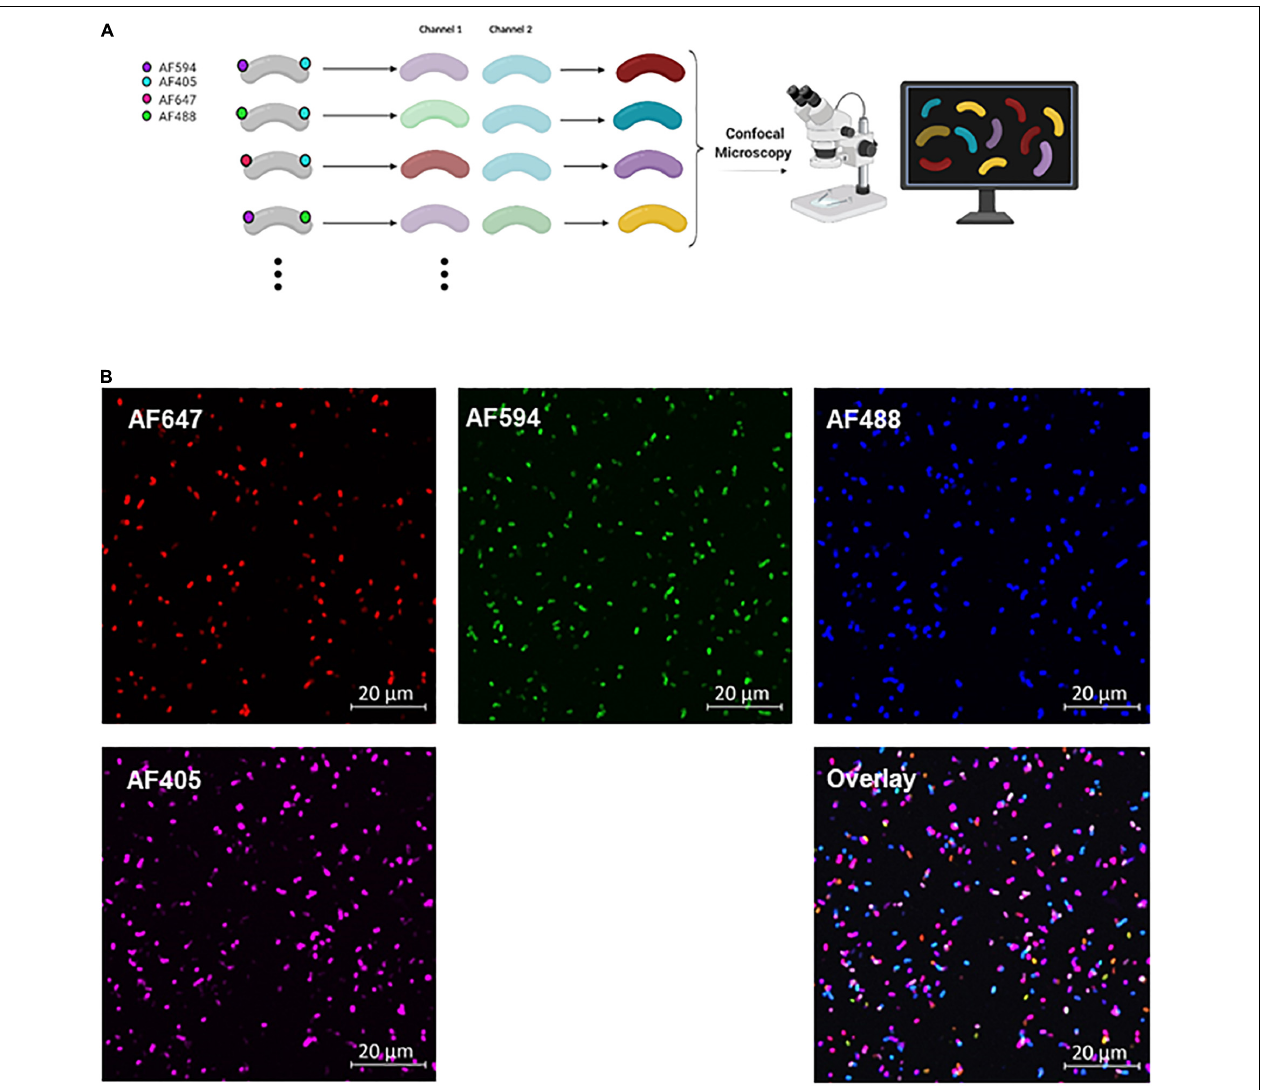
FIGURE 2 | COMBICK dual labeling with 4 fluorophores allows differentiation of up to 6 bacteria at once. (A) Schematic representation of the COMBICK method. Metabolic labeling of each bacteria with a combination of fluorophores results in a unique label that enables the differentiation of specific population of bacteria in communities. Combinatorically labeled bacteria can be analyzed by downstream applications (e.g., confocal microscopy). (B) Confocal images representing 6 differentially dual-labeled B. longum in a community with combinations of the fluorophores AF647, AF594, AF488, and AF405, each channel separately and the overlay of all